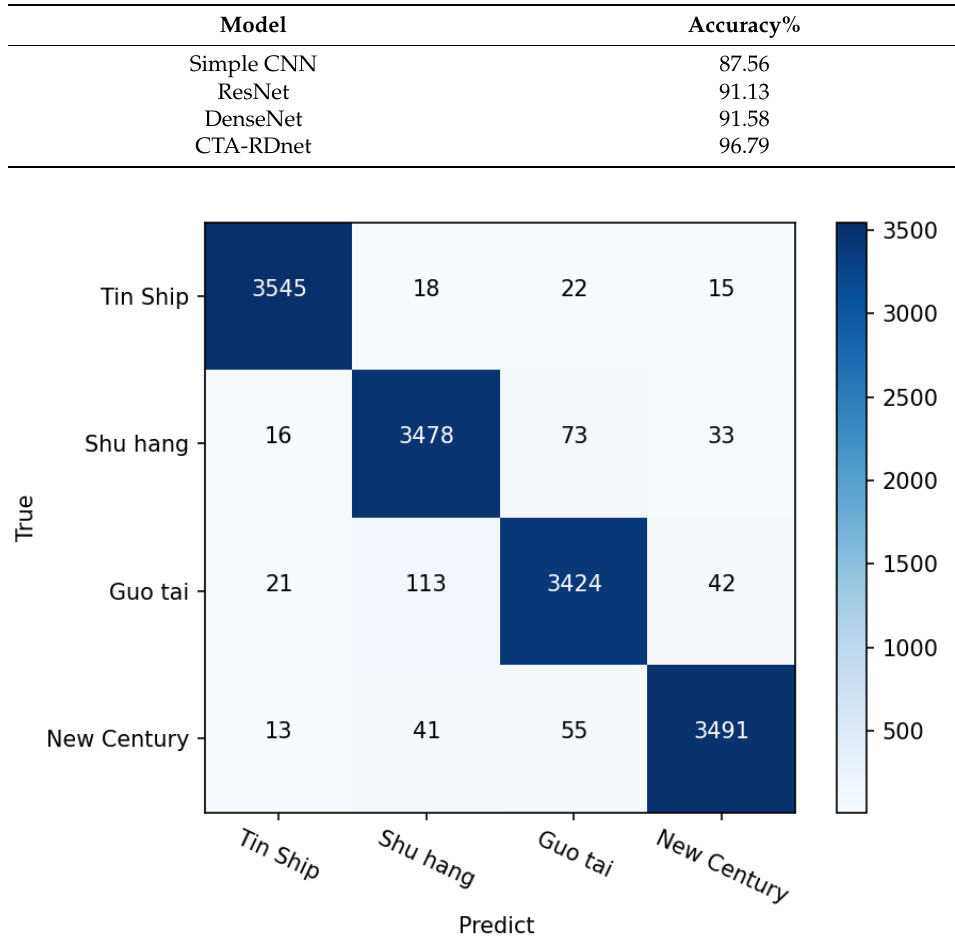
Figure 10. The confusion matrix of the CTA-RDnet.